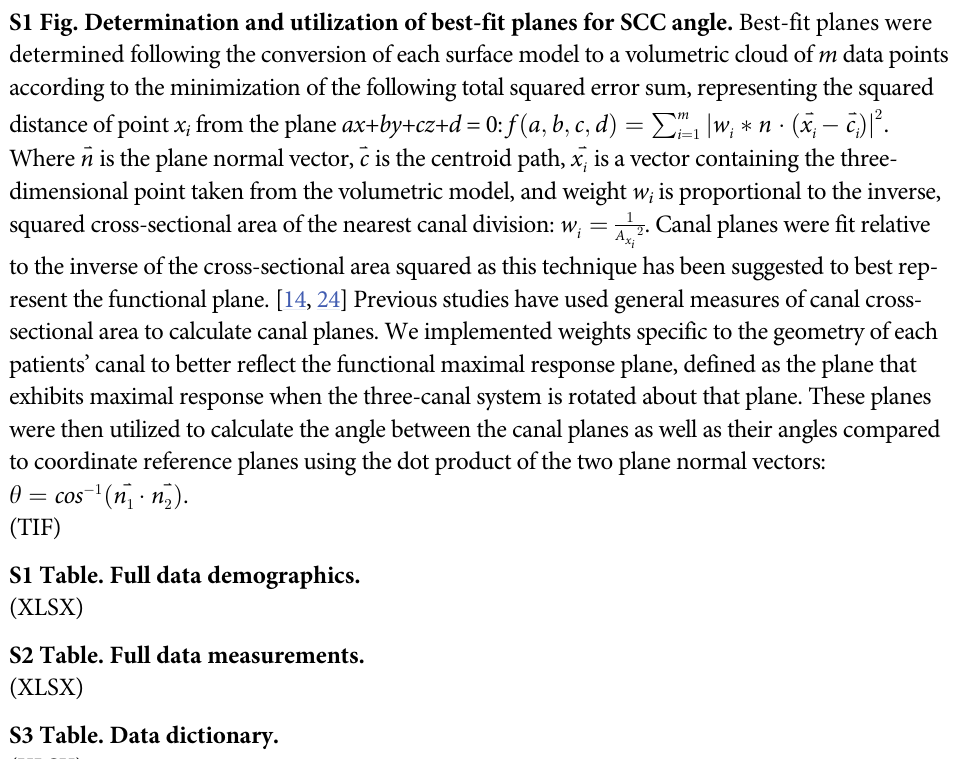
S1 Table. Full data demographics. S2 Table. Full data measurements. S3 Table. Data